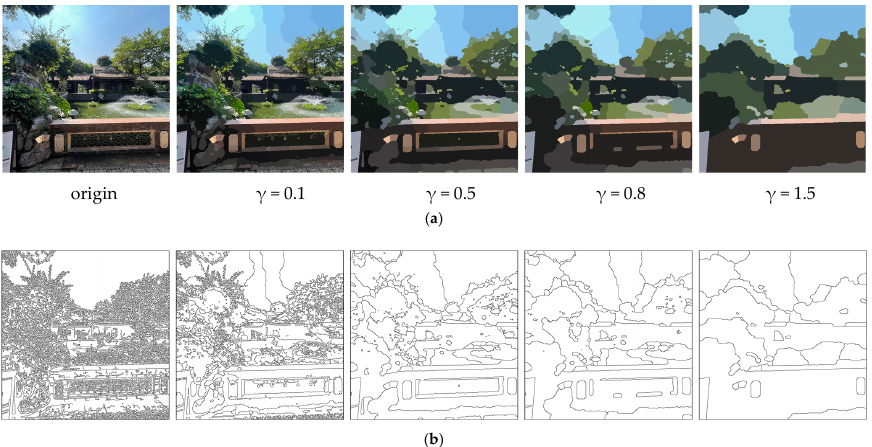
Figure 1. The image preprocessing, the image size is 640 × 640. ( a ) Potts segmentation procedure with different scale parameter γ ; ( b ) Canny edge detection.